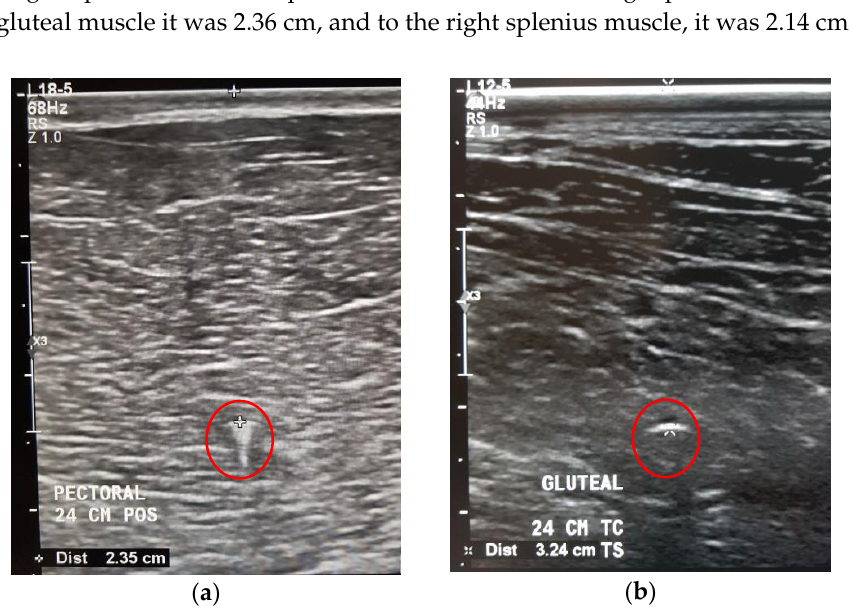
Figure 2. Ultrasound images of the right pectoral muscle ( a ) and right gluteal muscle ( b ) with a hyperechoic linear-structured microchip (red circle) within the muscle.